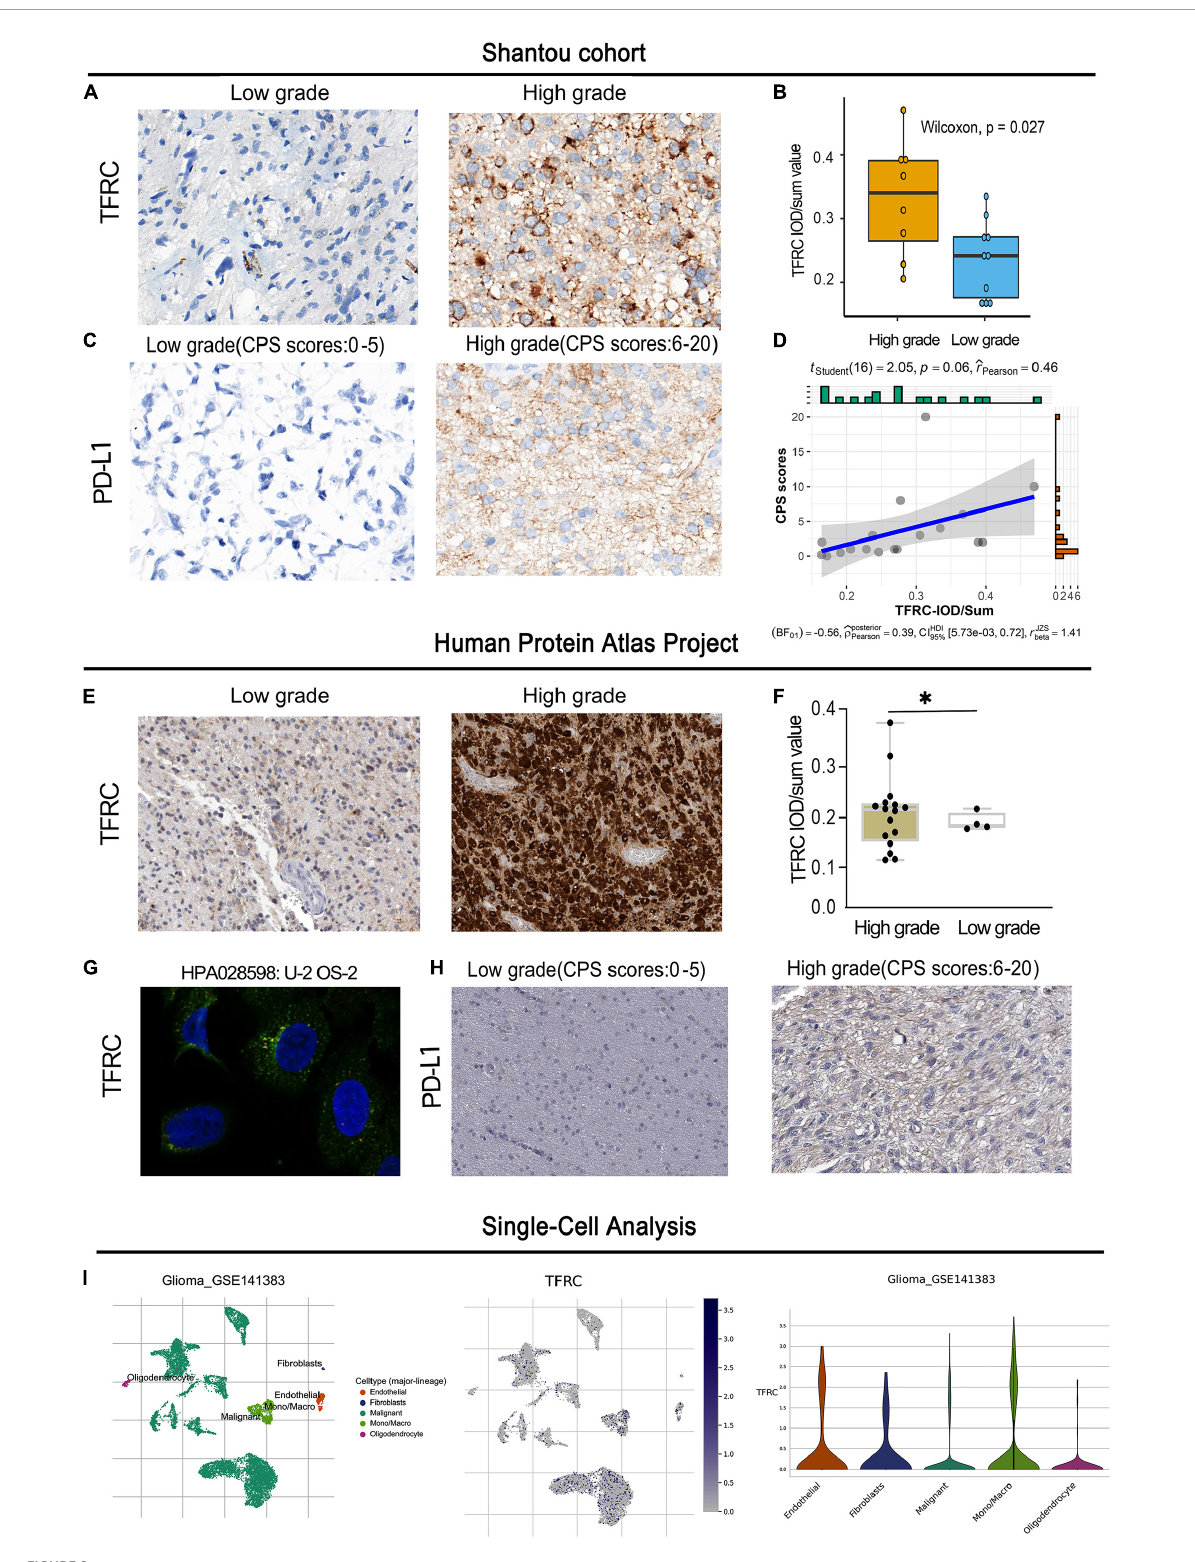
FIGURE8 Immunohistochemistry and single-cell analysis of TFRC and PD-L1 expression in LGG. (A–D) Shantou project. (E–H) Human Protein Atlas project. (I) Single-cell analysis of TFRC. ∗∗ p < 0.01.